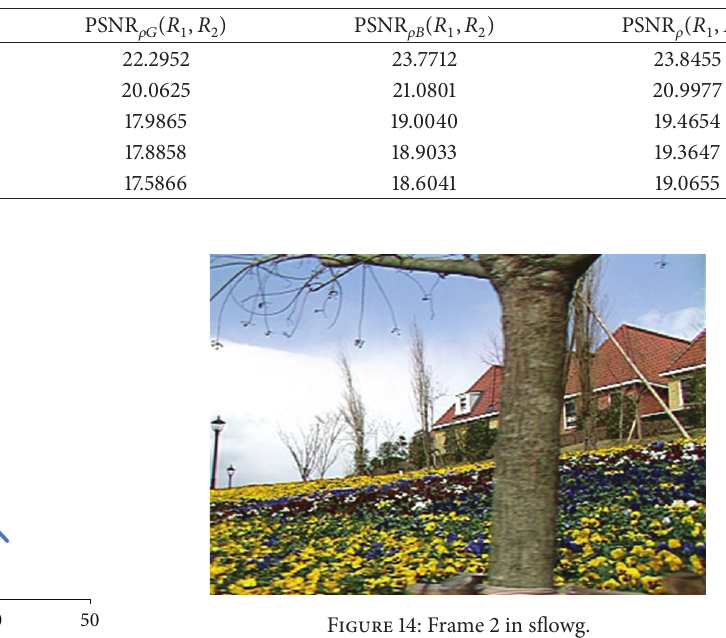
Figure 14: Frame 2 in sflowg.